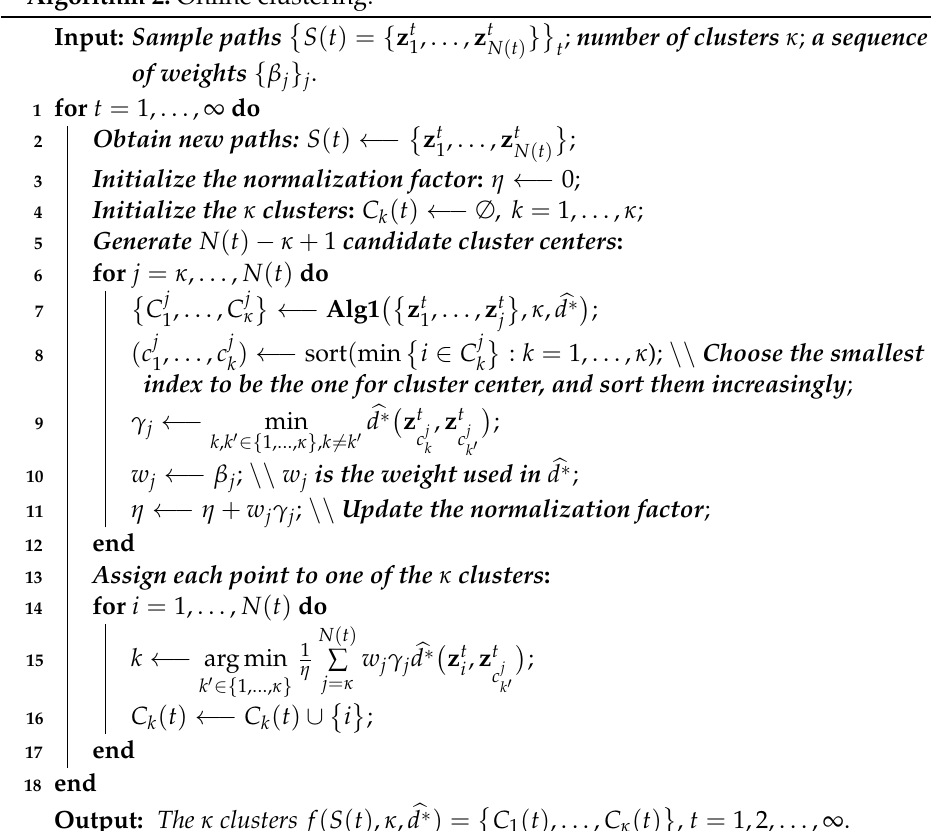
Algorithm 2: Online